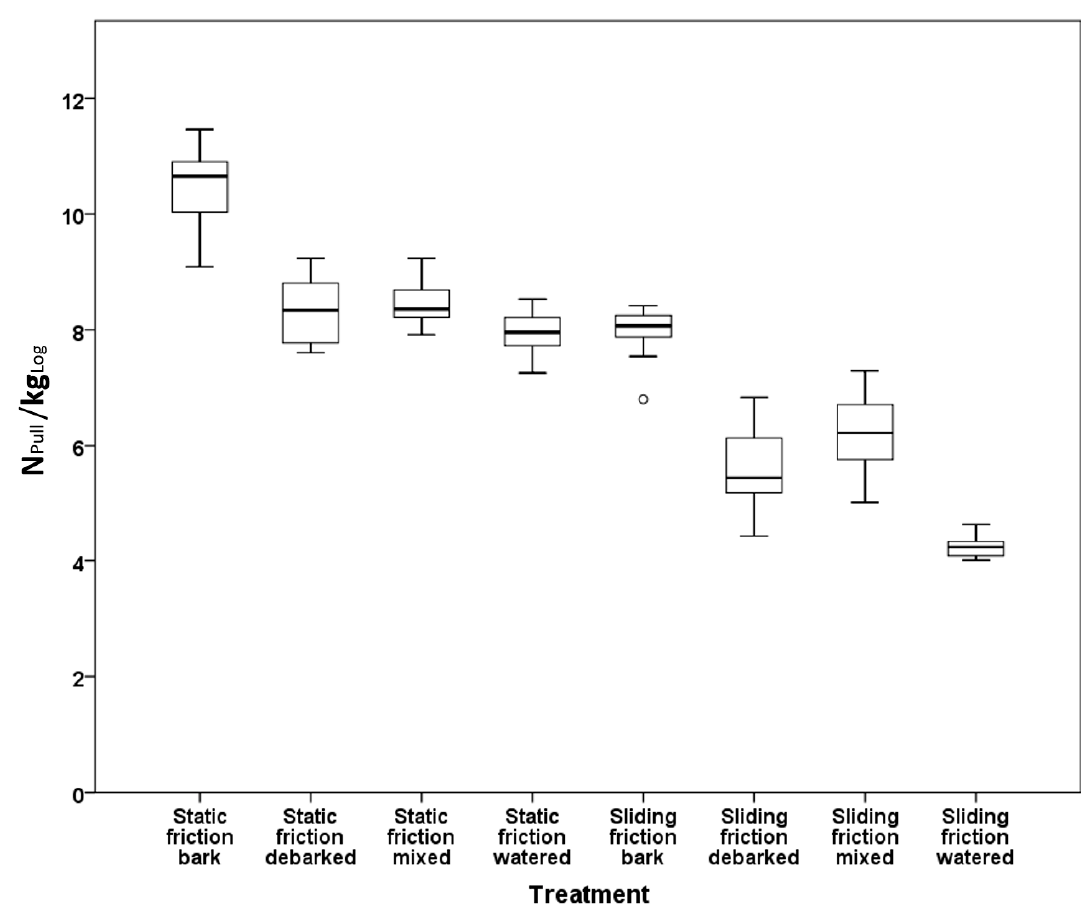
Figure 8. Boxplots showing the overview of the average static and sliding frictions in N Pull /kg Log of the four different treatments based on the 13 carried out test